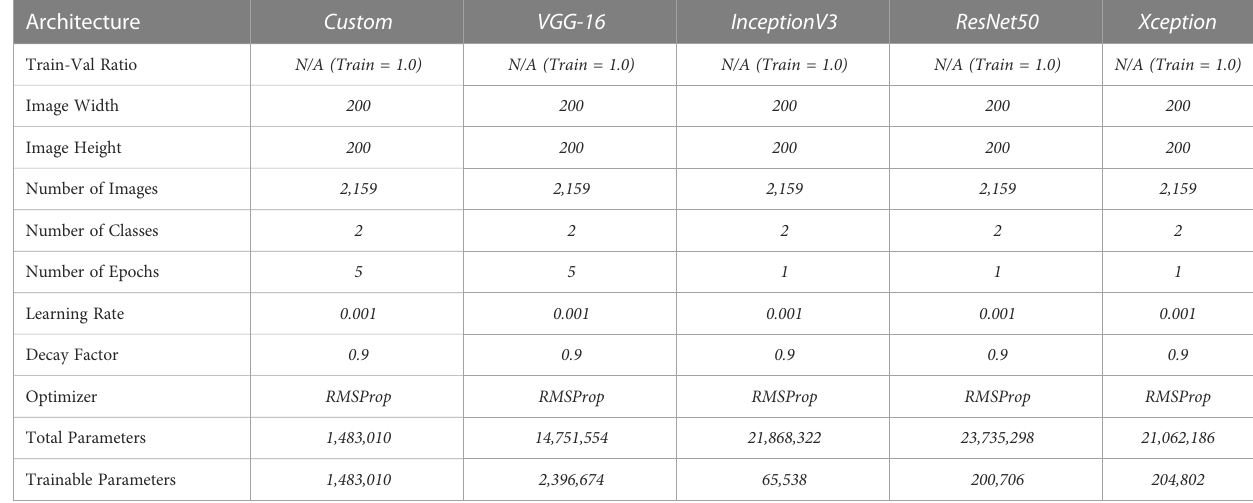
TABLE 2 Parameters for Models